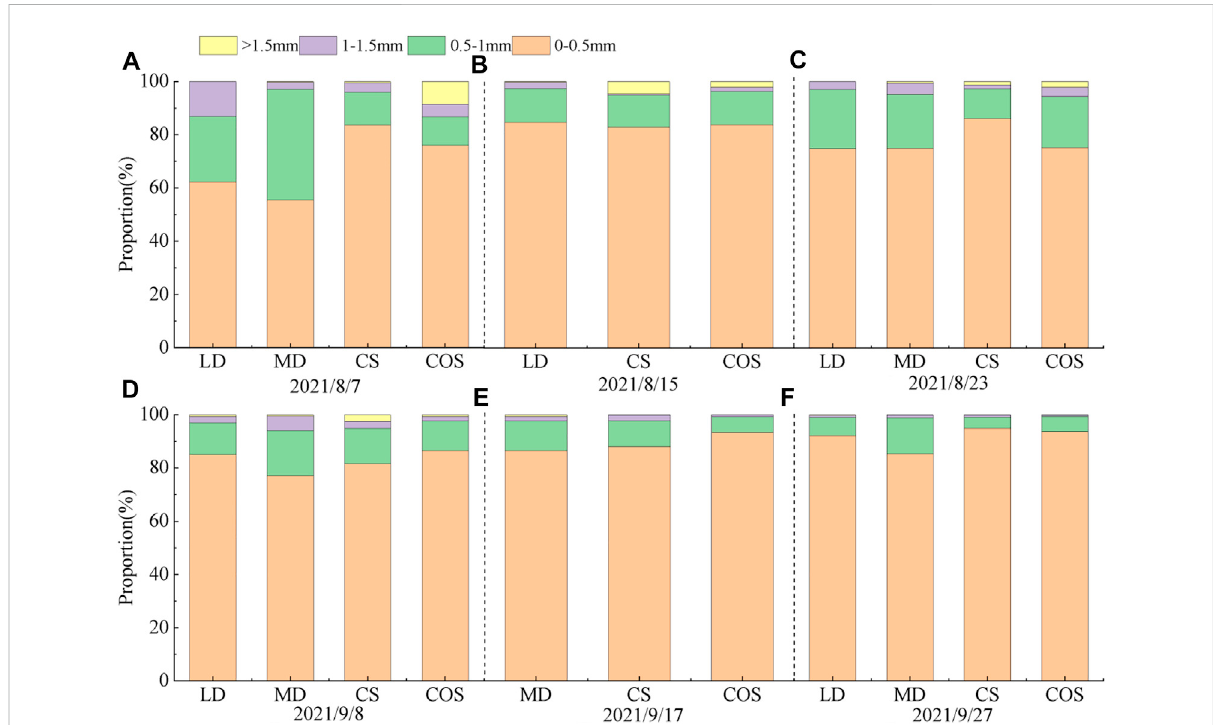
FIGURE 7 Proportionofrootlengthofdifferentdiameterclassesunderdifferentdroughtconditions. (A – F) aretheproportionofrootlengthwithdifferent diameters in 8/7, 8/15, 8/23, 9/8, 9/17, 9/27 in 2021, respectively.